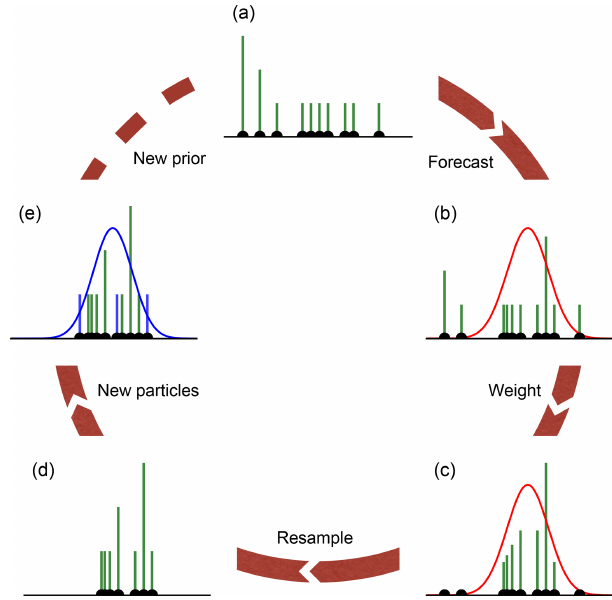
Figure 2. Illustration of the particle filter with covariance resam- pling. The green bars show the weight of each ensemble member (10 in this example), and the black dots show the position of them. (a) The prior represented through the ensemble. (b) The ensem- ble is propagated to the next observation (depicted as Gaussian dis- tribution; red curve). (c) The particles are weighted according to the observation. At this point, some particles have already negli- gible weight. (d) The universal resampling drops particles with low weight (three in this example). Instead of adding new particles at the same position, only the weights of the kept particles are changed. If a particle is resampled k times, it will get the weight kN − 1 . The ensemble size is reduced, and new particles have to be added to conserve the ensemble size and to avoid filter degeneration. (e) The new particles are drawn from the full covariance of the ensemble (Eq. 13), and their weight is set to N − 1 . Since new particles with weights are added to the ensemble, it is necessary to normalize the weights to 1 again. This results in the posterior, which is the prior for the next assimilation cycle. The pseudocode for the algorithm can be found in Appendix A.